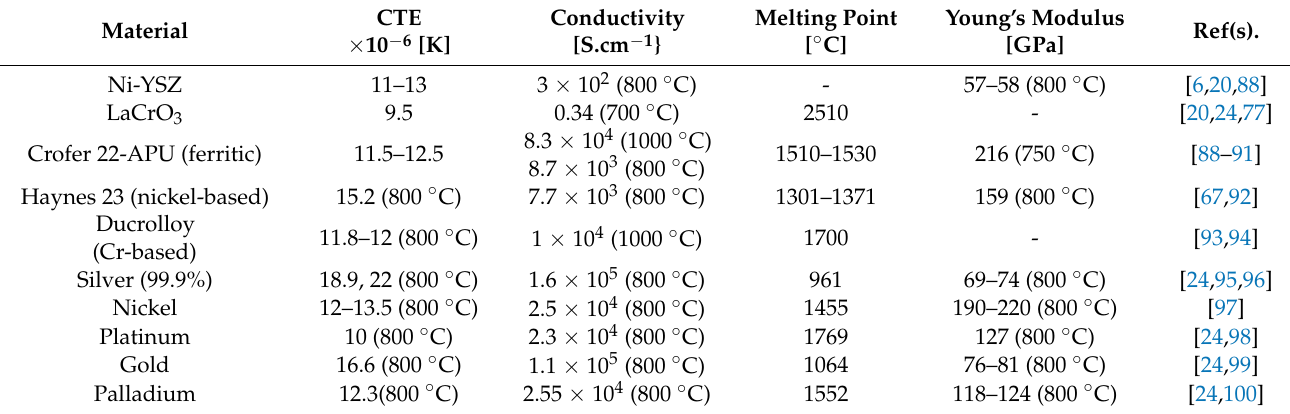
Table 2. Material properties of commonly used SOFC interconnect materials. Typical anode material, Ni-YSZ included for